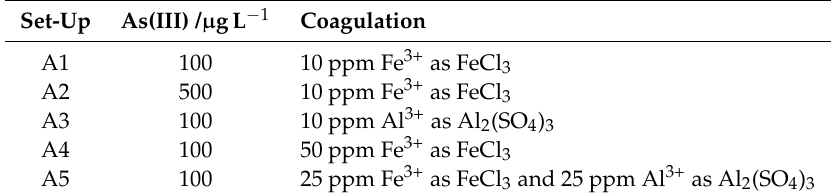
Figure 1. Process flow scheme of pilot tests: ( 1 ) Filling of raw water; ( 2 ) Dosing of coagulant and aeration (with or without NTP); ( 3 ) Sedimentation and ( 4 ) Filtration. Table 1. Overview of process set-ups with coagulation and filtration only and a coagulation time of 30min (no aeration).